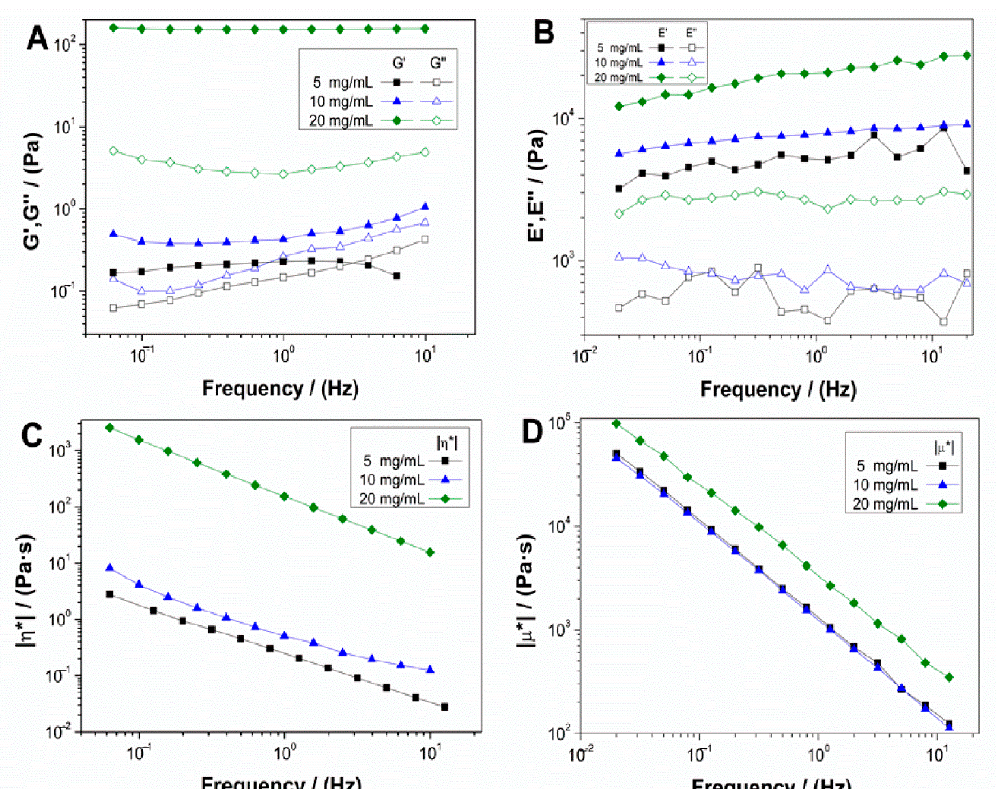
Figure 1. Evolution of elastic (G ′ and E ′ ) and viscous (G ″ and E ″ ) moduli and complex viscosity ( η * and μ *) of collagen-based hydrogels ( A , C ) and aerogels ( B , D ) at different collagen concentrations (5, 10 and 20 mg/mL).